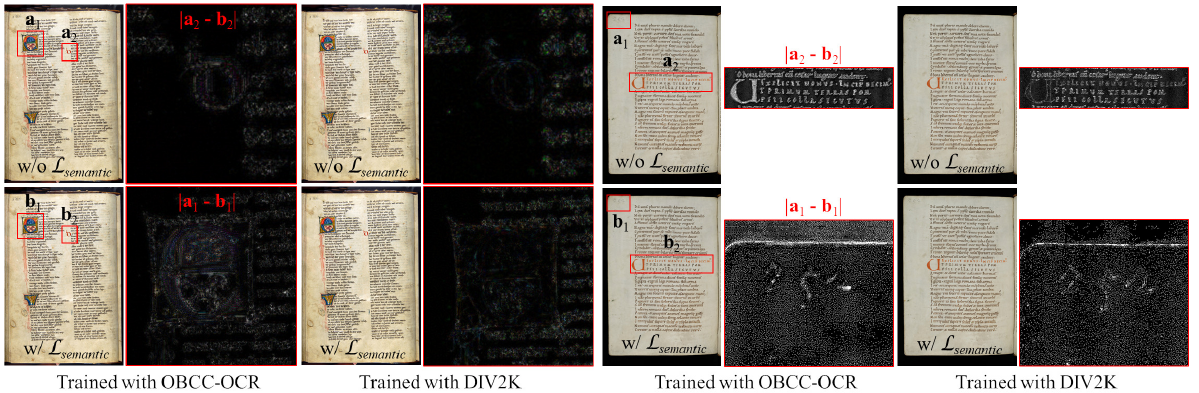
Figure 5. Visual comparison of text SR images with the semantic loss between training using OBCC-OCR and DIV2K. The difference images were equally boosted to improve visibility.